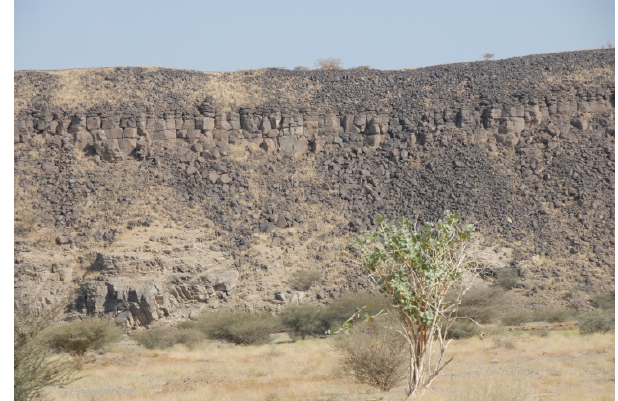
Figure 8. Eroded basaltic boulders of the harrat ( a ) trap water during rainfall events and it ponds atop the underlying clay ( b ). The water flows downhill on the clay surface to where it intersects fractured rocks along the perimeter walls of the wadi. The fractured rock conducts the water downward into the low hydraulic conductivity beds within the alluvial sequence, thereby providing perimeter recharge.